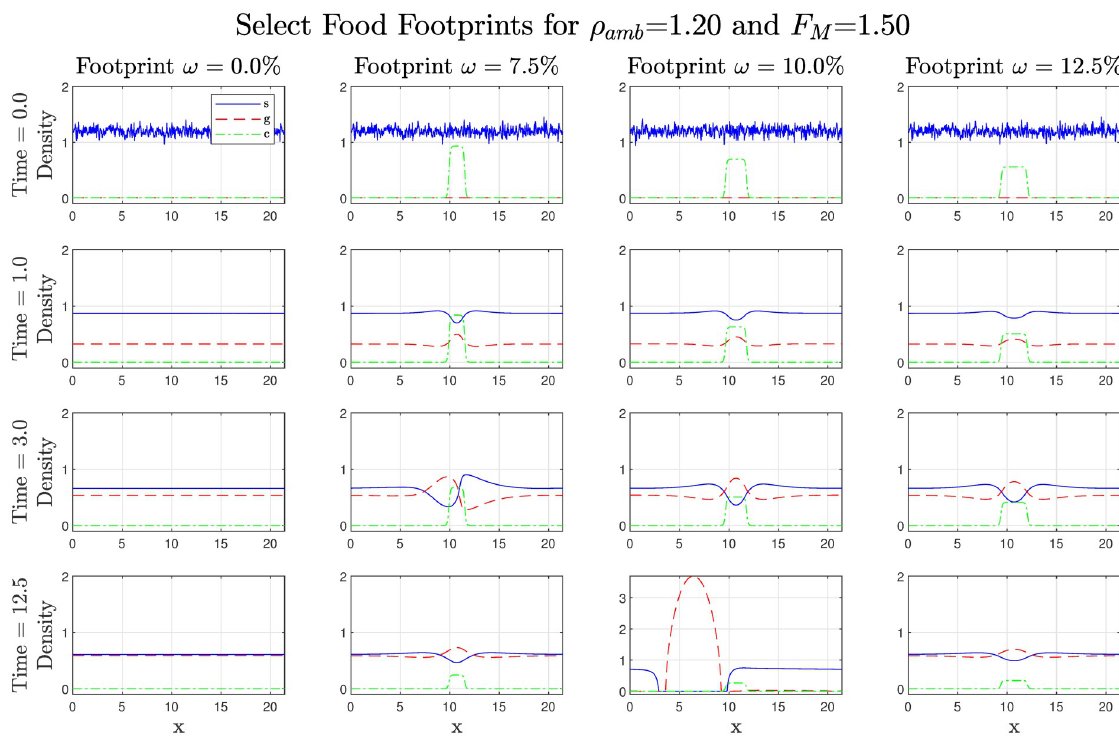
Fig 6. A selection of plots showing the effect of food distribution on gregarisation and locust group formation with symmetric parameters. In these simulations ρ = 1.2, κ = 0.09, and F = 1.5 with ω = 7.5%, 10%, and 12.5%, as well as with no food present (labelled amb M ω = 0%). In the plots, blue is solitarious, red is gregarious, and green is food. If the food source is too narrow ( ω = 7.5%, t = 3) there is an attempt at group formation but the gregarious mass is too small and a large portion remains within the food source, thus the group does not persist. If the food is too wide ( ω = 12.5%) the gregarious locusts simply cluster in the center of the food and do not attempt group formation. Finally, if the food width is optimal ( ω = 10%) there is a successful group formed, this is seen as clump or aggregation of gregarious locusts in the final